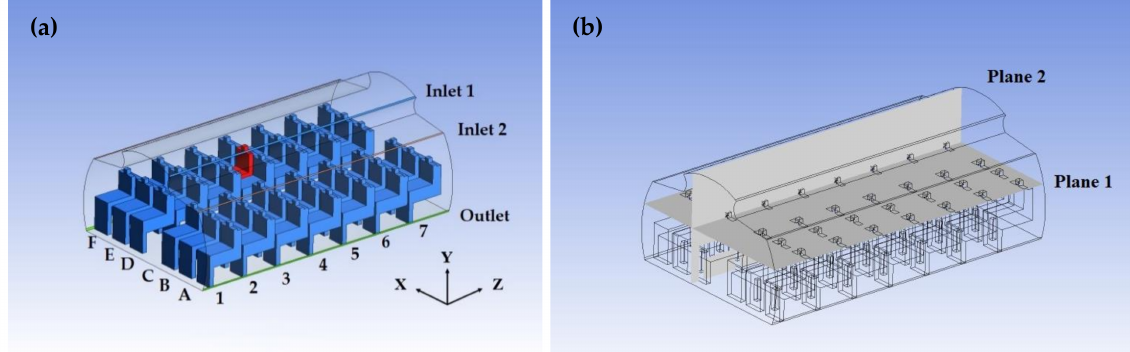
Figure 1. The physical model of the seven-row A320 cabin: ( a ) virus carrier seat in red; ( b ) plane 1 and plane 2.